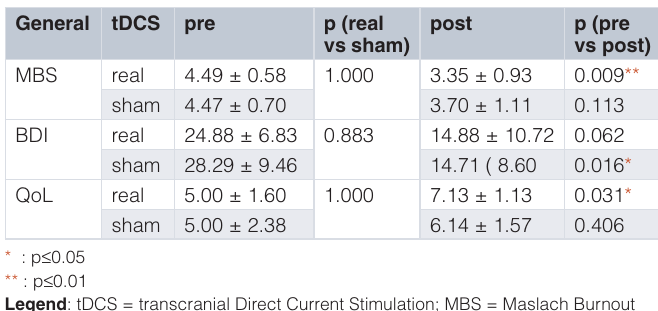
Table 3. Pre- and postscores and p-values of the burnout and depression assessments and the Quality of Life questionnaire per group.